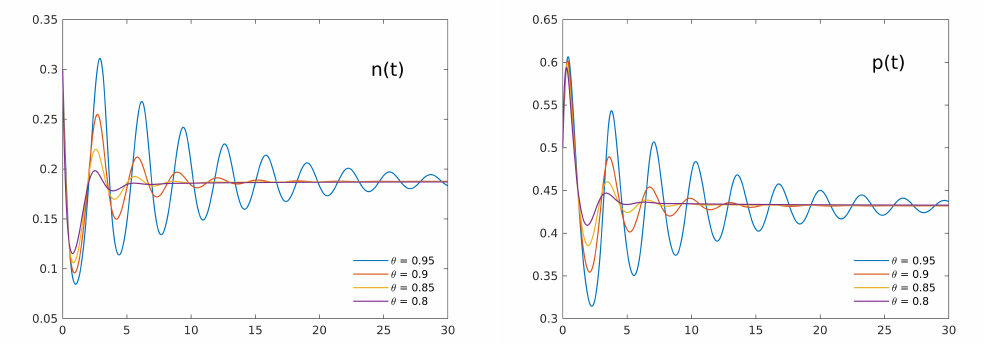
Figure 4. Trajectories for the numerical approximations PI2 of the solutions of system (3) for different θ values (0.95, 0.9, 0.85, 0.8) for both populations ( n ( t ) shown in the left panel, p ( t ) in the right one). The stabilizing effect of the fractional operators can be clearly